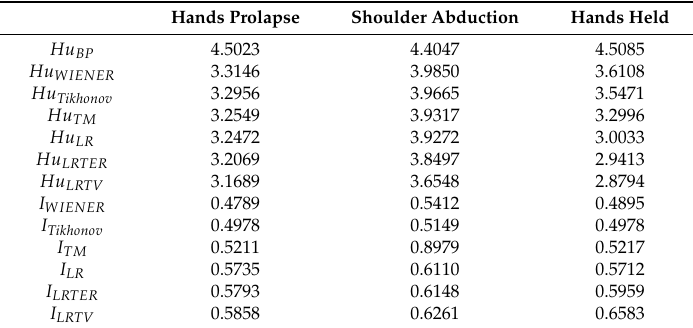
Table 5. Image information entropy and mutual information with different algorithms in real data measurement.